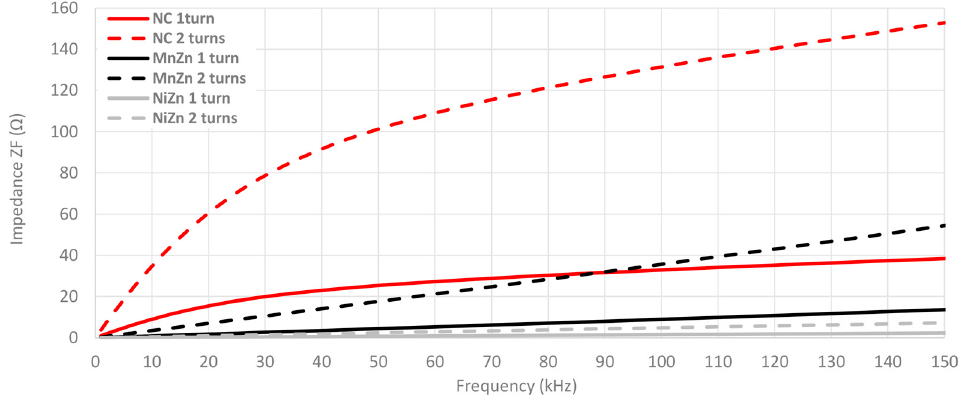
Figure 12. Impedance comparison of the three cable ferrites measured with 1 and 2 turns in the low frequency range.